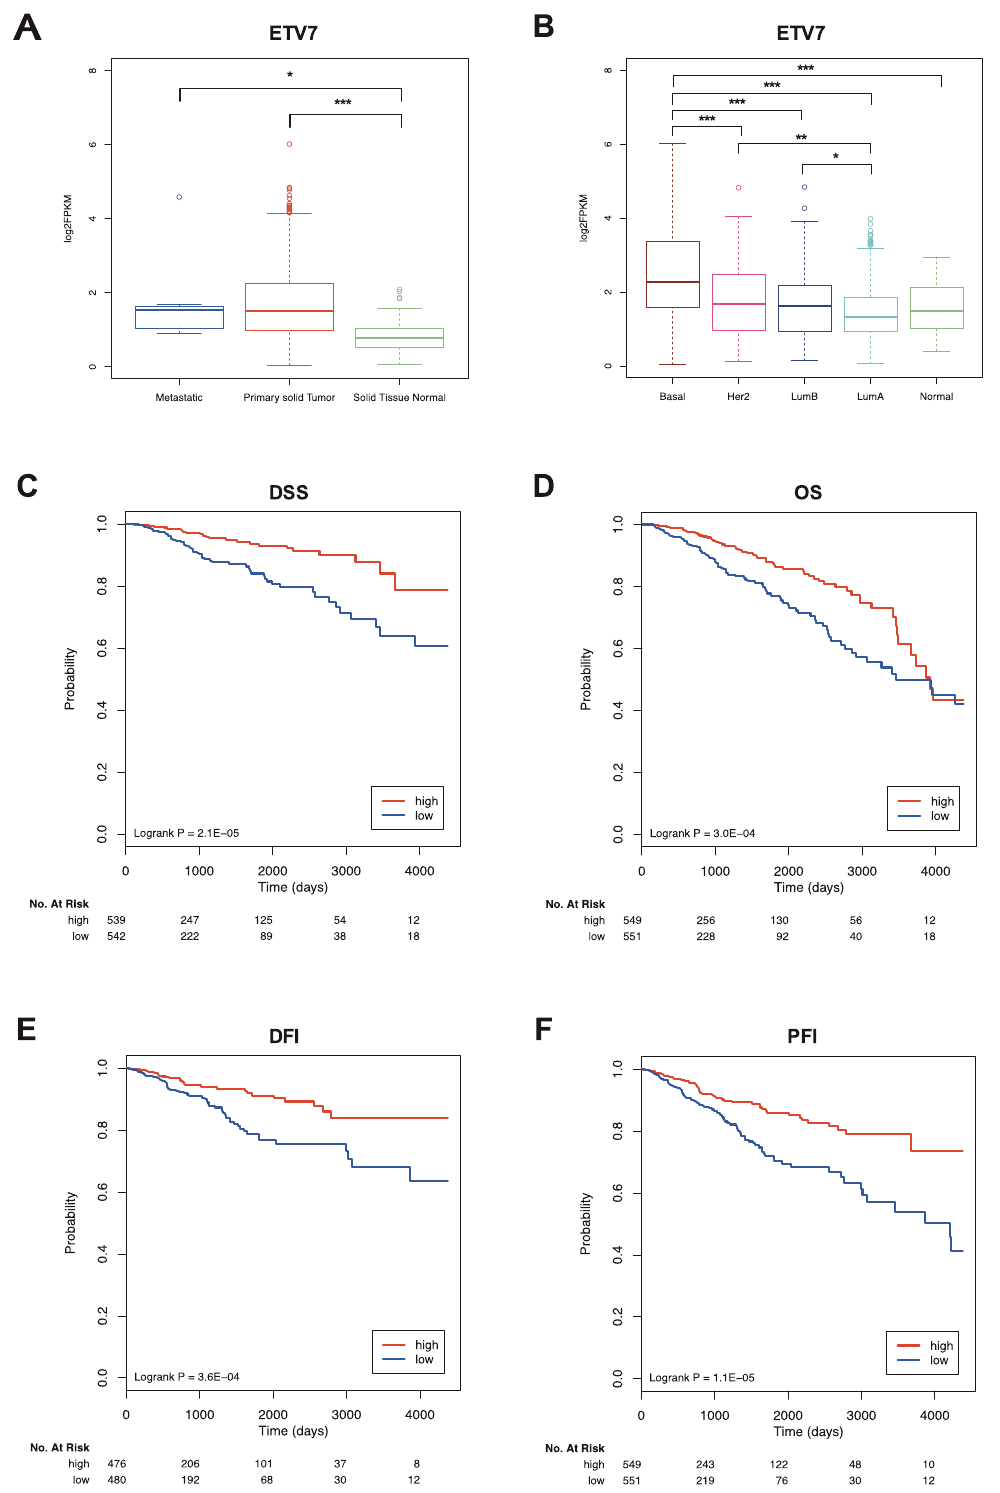
Fig. 6 The expression of ETV7 and ETV7-repressed interferon signature genes have prognostic value in breast cancer. A , B ETV7 expression in TCGA BRCA samples classi fi ed by tissue type ( A ) and PAM50 molecular subtype ( B ). Plot whiskers extend to the most extreme data point which is no more than 1.5 times the interquartile range from the box. The signi fi cance is calculated with ANOVA and post-hoc Tukey test. * p -value < 0.05; *** p -value < 0.001. C – F Kaplan – Meier curves for TCGA breast cancer patients strati fi ed according to the average expression of ETV7-regulated IFN-responsive gene signature. Curves represent the probability of disease-speci fi c survival (DSS) ( C ), overall survival (OS) ( D ), disease-free interval (DSI) ( E ) and progression-free interval (PFI) ( F ). p -values are calculated with logrank test.